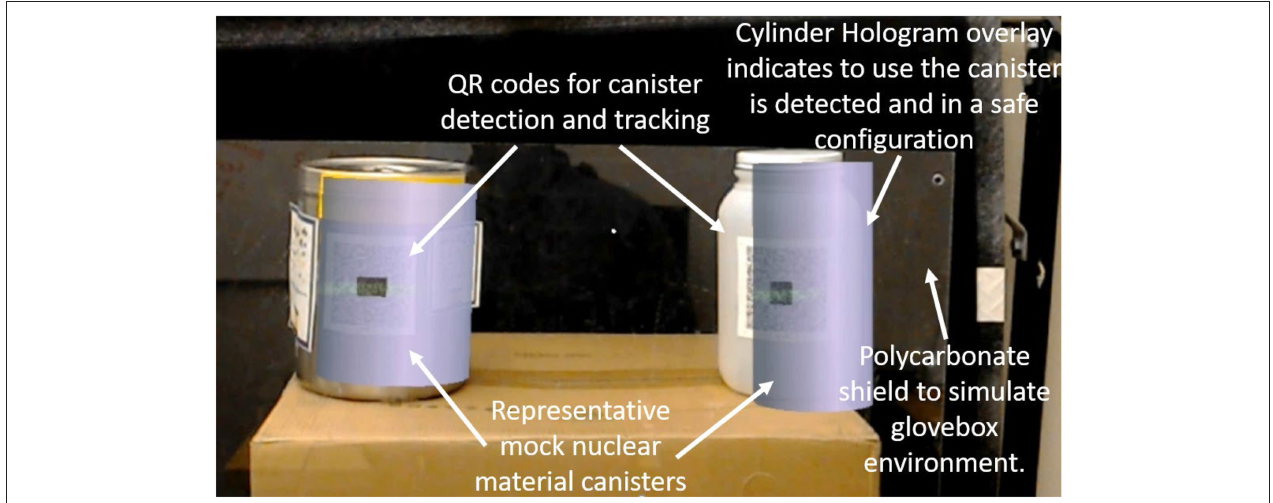
FIGURE 13 | Mock glovebox setup for demonstrating how augmented reality headsets can aid glovebox technicians with nuclear criticality safety, information retrieval, and documentation.